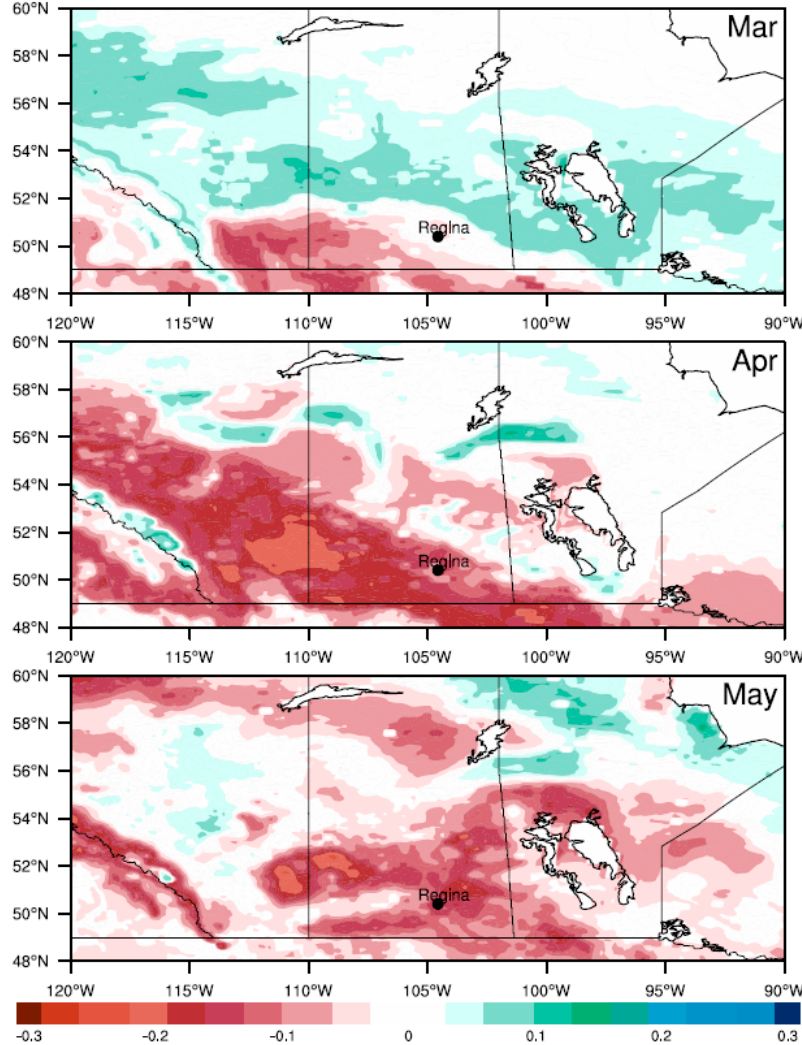
Figure 10. WRF simulated difference (ELX-LAX) in spring soil moisture (m 3 m − 3 ). Table 3. Difference between 2016 and 2011 of observed soil moisture (first 5 cm) in volume % in Alberta (AB).